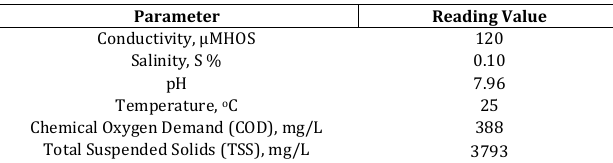
Table 2: Proximity analysis results of collected wastewater